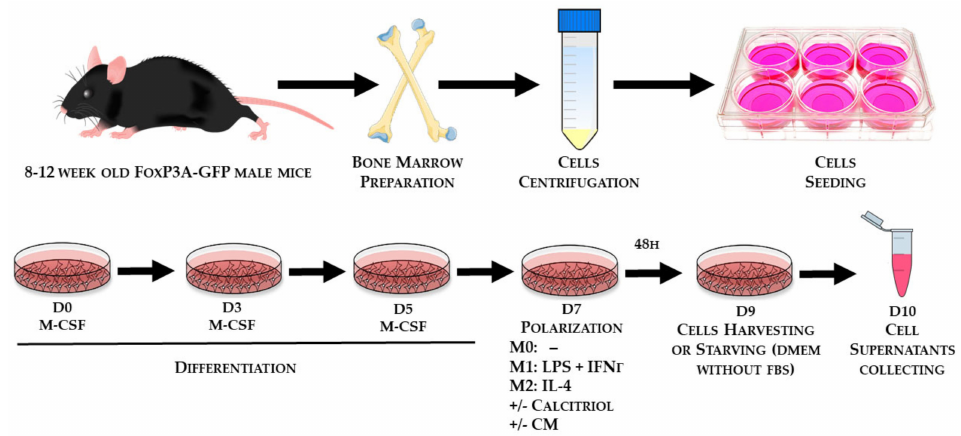
Figure 9. Scheme illustrating the isolation of bone marrow progenitor cells and their di ff erentiation into macrophages of the respective